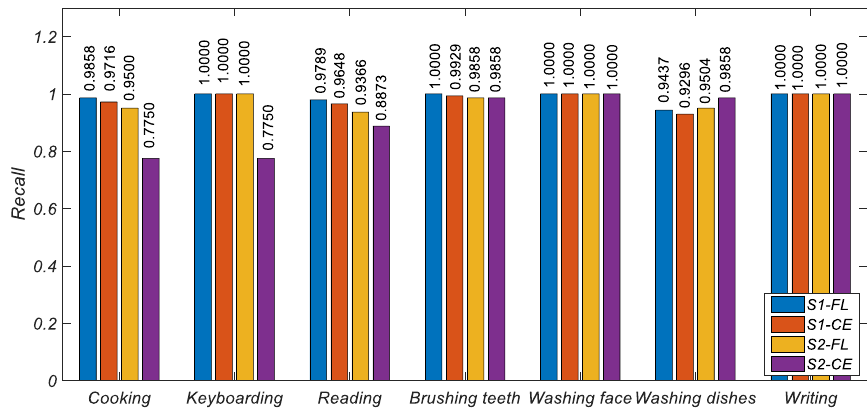
Figure 8. The F1-score comparison of HAR-CE and HAR-FL in each class. By adjusting the γ value in the focal loss function, the weight of easily classic samples and hard classic samples in the loss function can be dynamically adjusted, so that the model can focus more on hard classic samples. In the case of S2, the balance weight α is set to 0.25, the learning rate is 2 × 10 −4 , and the Adam optimizer is used. When batch_size is set to 128, Figures 9 and 10 show the curve of accuracy of training set and validation set with a different epoch when parameter γ is different. It can be seen from the figure that the overall trend of accuracy of the training set and validation set tends to 1 as the epoch increases, and the performance when γ is 2 is better than that when γ is other values.